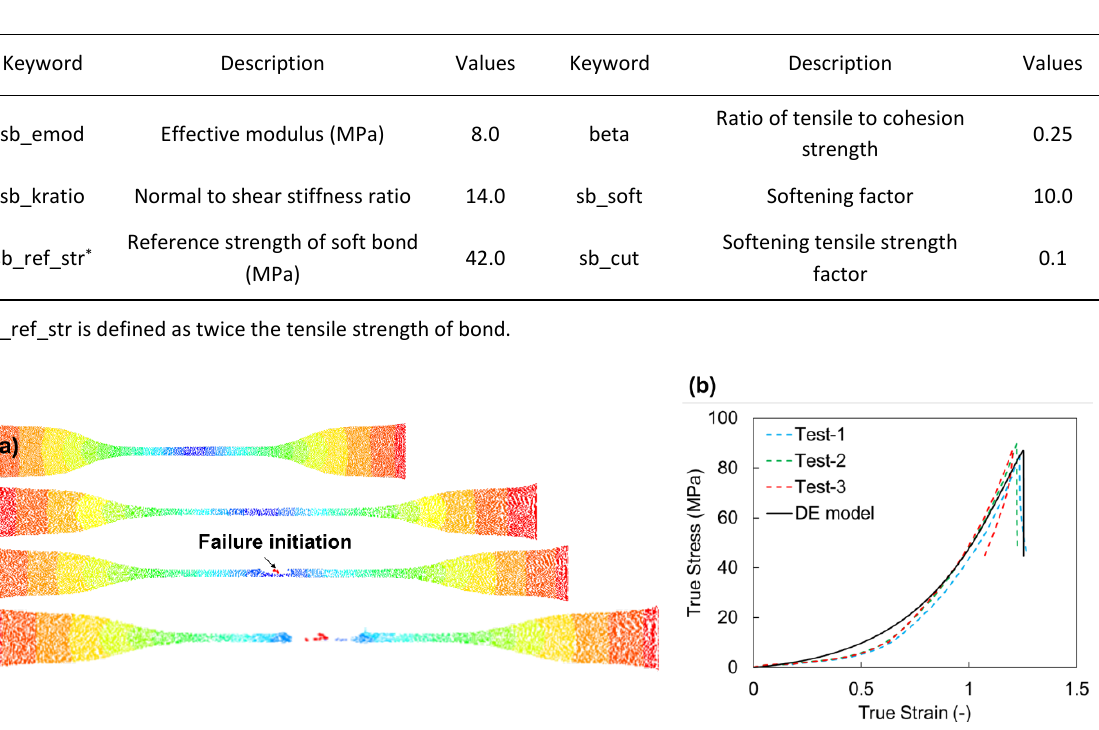
Table 1: Calibrated microscopic bond parameters of PVB interlayer